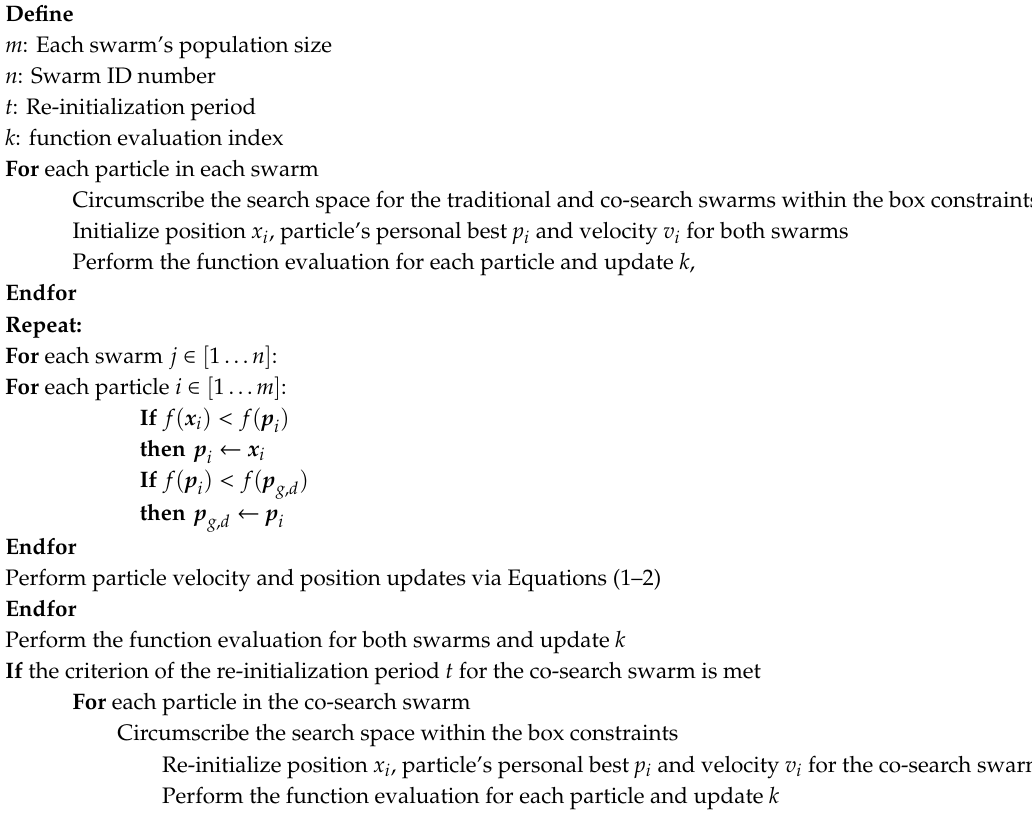
The Enhanced Partial Search Particle Swarm Optimization (EPS-PSO) Algorithm